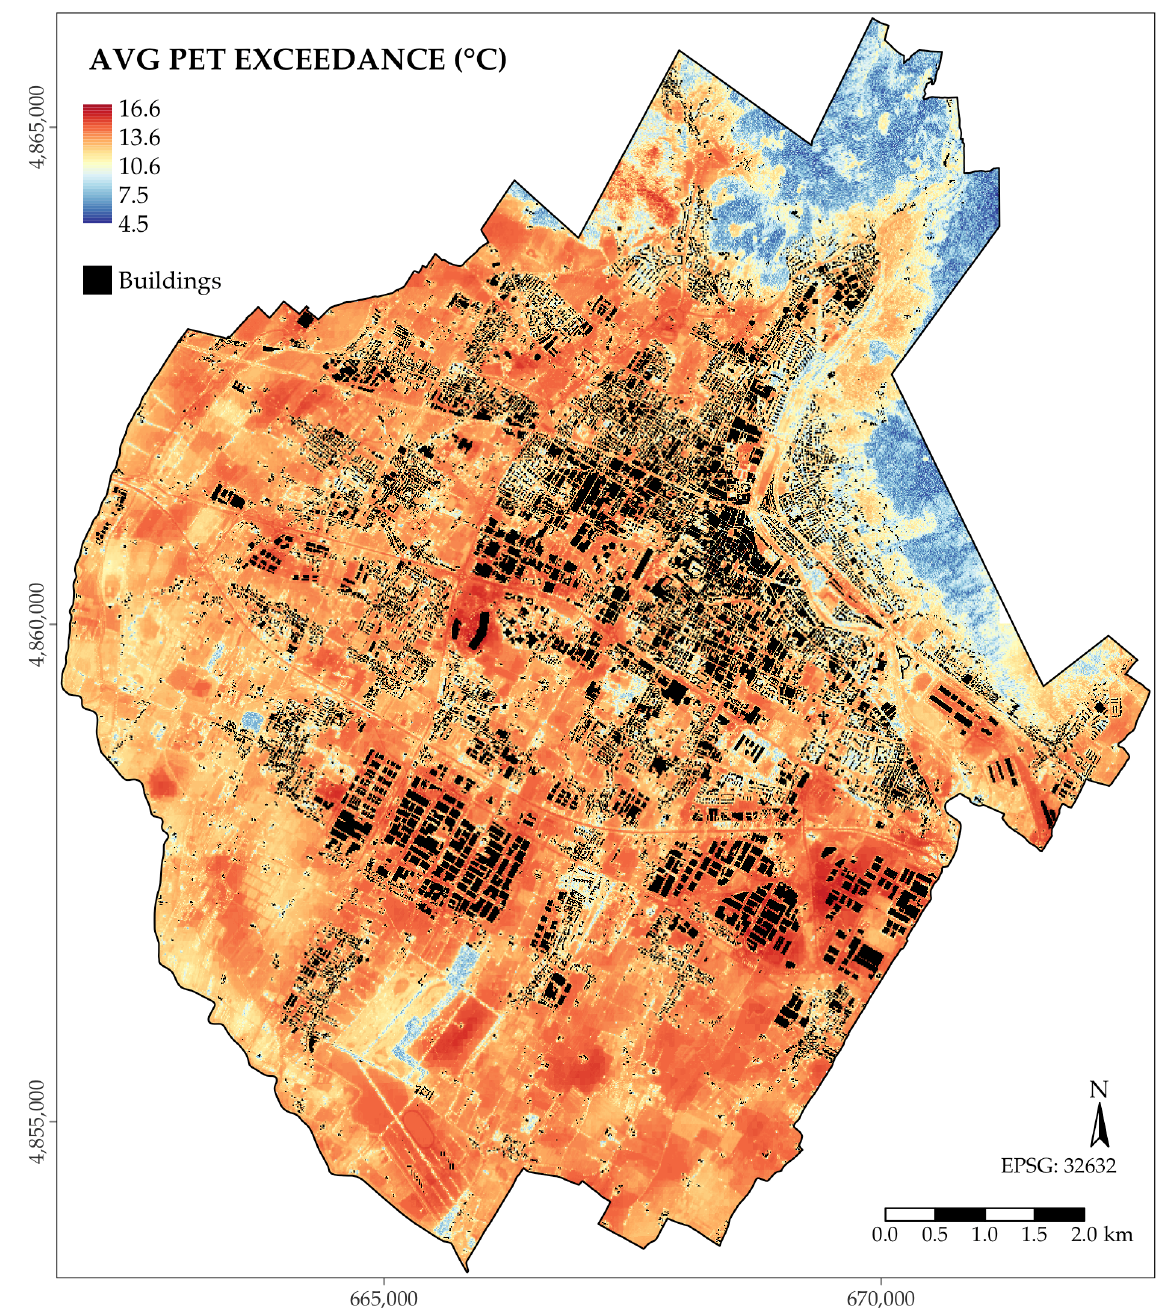
Figure 12. Average (AVG) PET exceedance map for the study area.